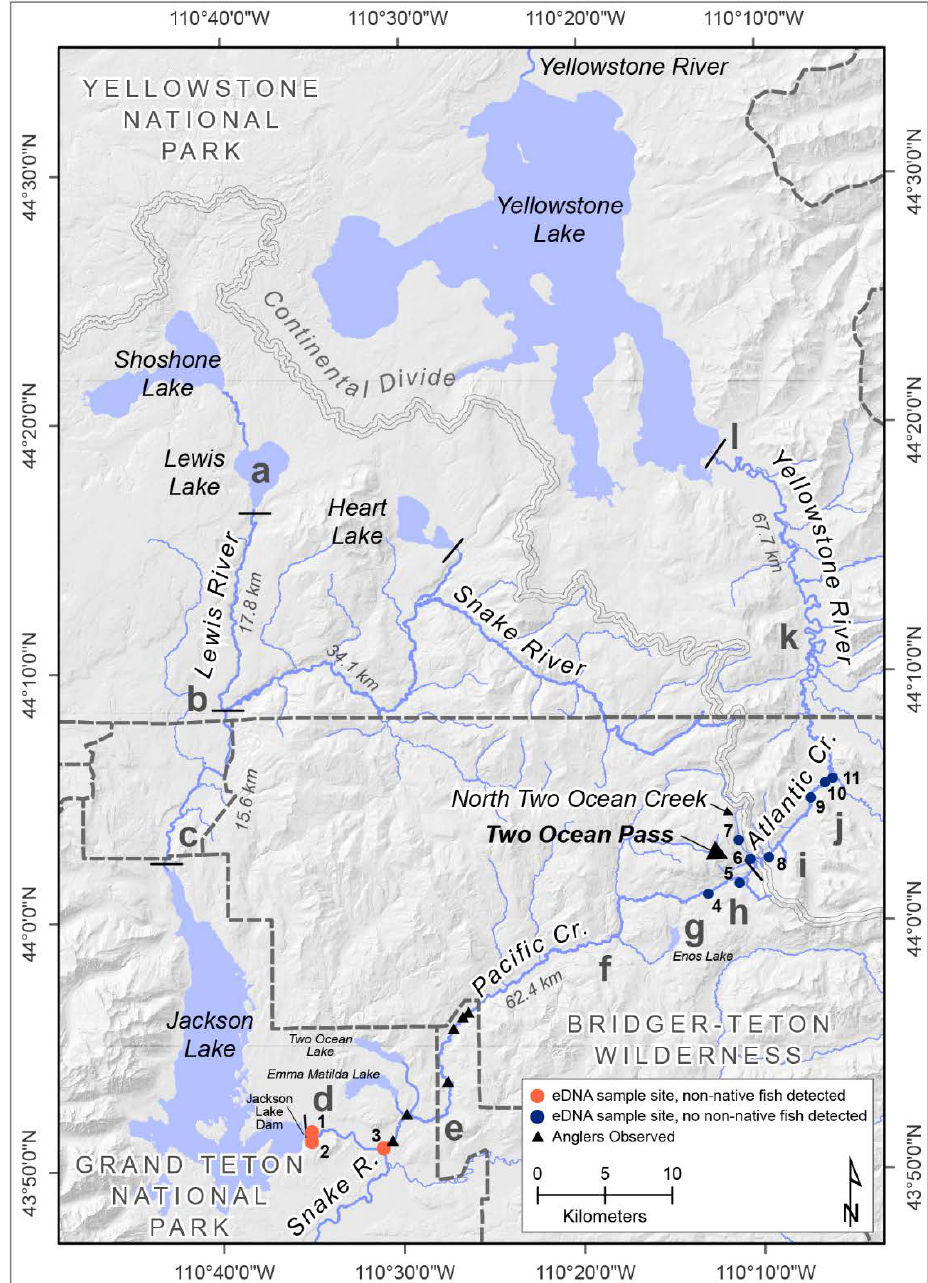
Figure 3. Headwaters of the Atlantic and Pacific drainages where they unite on Two Ocean Pass within the Bridger-Teton Wilderness, Wyoming. North Two Ocean Creek flows down the Continental Divide and branches into Atlantic Creek, a Yellowstone River tributary flowing to the east, and Pacific Creek, a Snake River tributary flowing to the west. No barriers to the movement and mixing of fish between Atlantic and Pacific creeks exist. The distances (km) are river lengths between hash marks (—). The letters (a–l) are locations of aerial photographs shown in Figure 4. To validate the results of the eDNA survey, we electrofished 205- and 437-m reaches using a backpack electrofishing unit (Smith-Root, Inc., Model LR-24) at sites 4 and 5, respectively, on upper Pacific Creek near Two Ocean Pass. Angling was used on the Snake River, upper and lower Atlantic Creek, and the Yellowstone River as an additional validation method for fish because those waters were too large to be effectively sampled with a backpack electrofishing unit. In addition, on 8 and 11 July, 2019, aerial surveys for anglers were conducted by helicopter to record the GPS locations and number of anglers throughout the study area, including waters upstream of eDNA sampling sites.